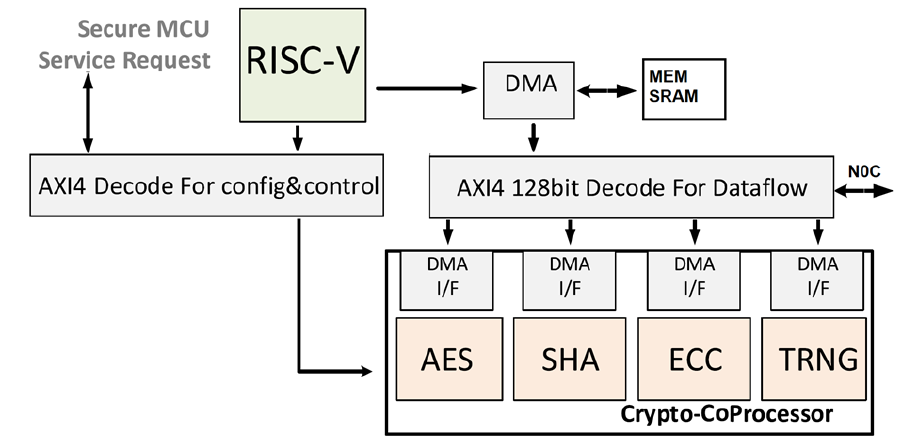
Figure 1. The hardware architecture of the proposed